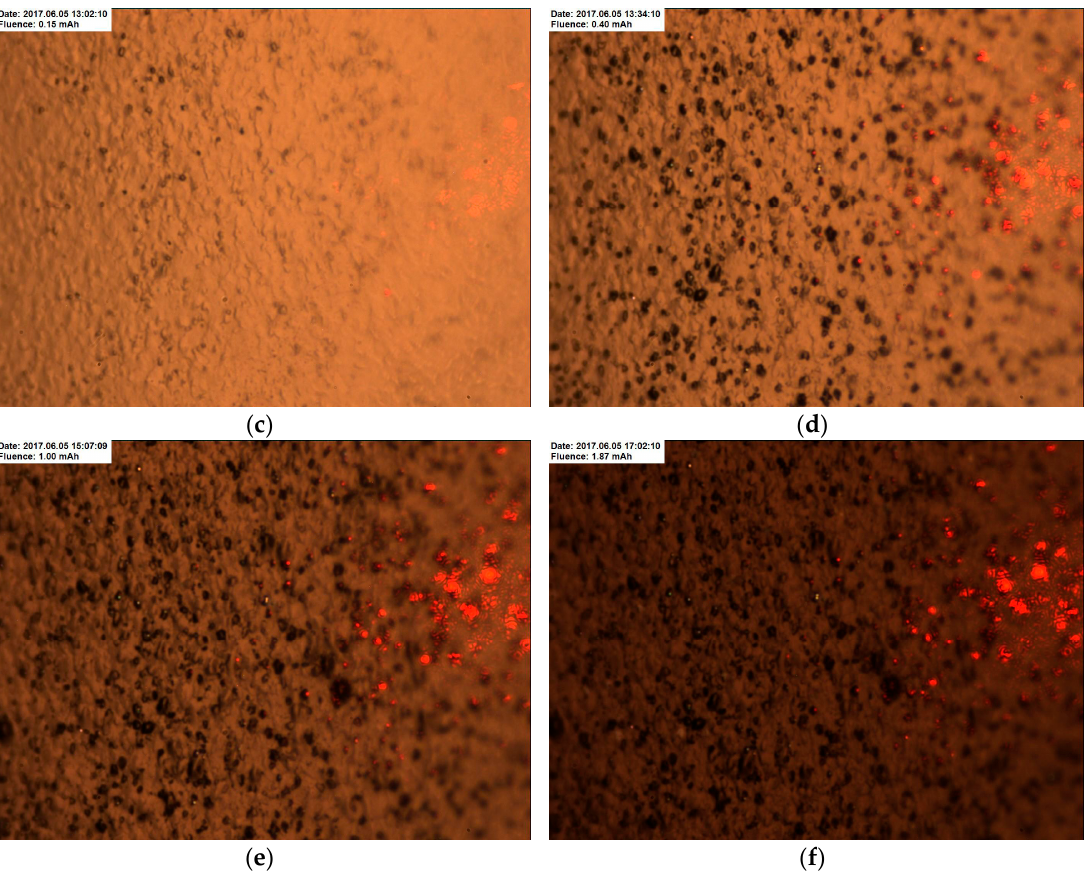
Figure 9. Images of the surface of 99.996% fine copper during irradiation by a 2-MeV proton beam with varying integrals of the current: ( a ) 0, ( b ) 0.01, ( c ) 0.15, ( d ) 0.40, ( e ) 1.00, ( f ) 1.87 mA·h. The frame size is 9 mm horizontally and 4 mm vertically.